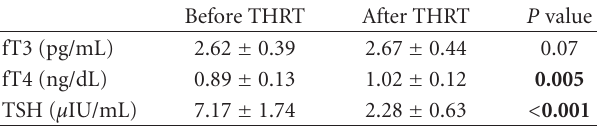
Table 1: Thyroid function tests before and after thyroid hormone replacement therapy (THRT).